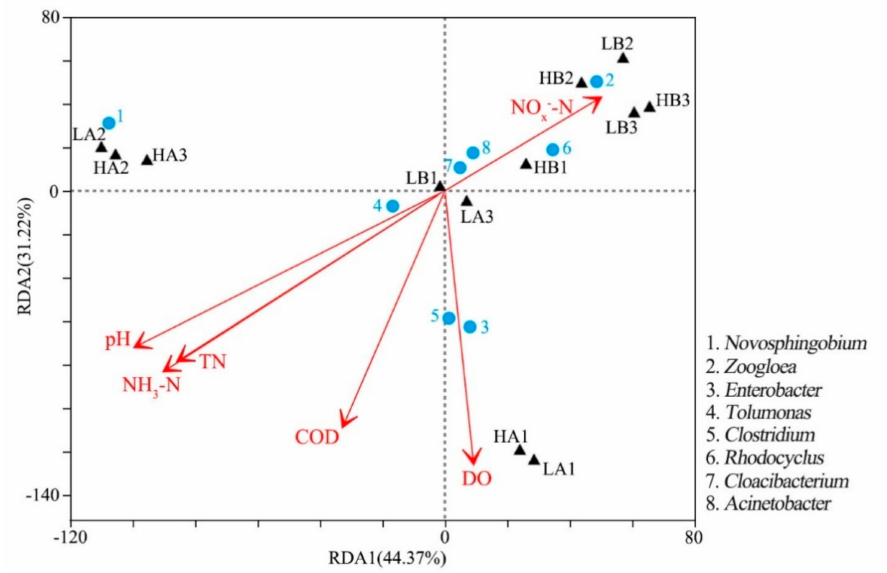
Figure 4. Redundancy analysis (RDA) map based on the sequencing data and environmental variables. The black triangle represents the sample, the blue dot represents the microbial at the genus level, and the arrow represents environmental